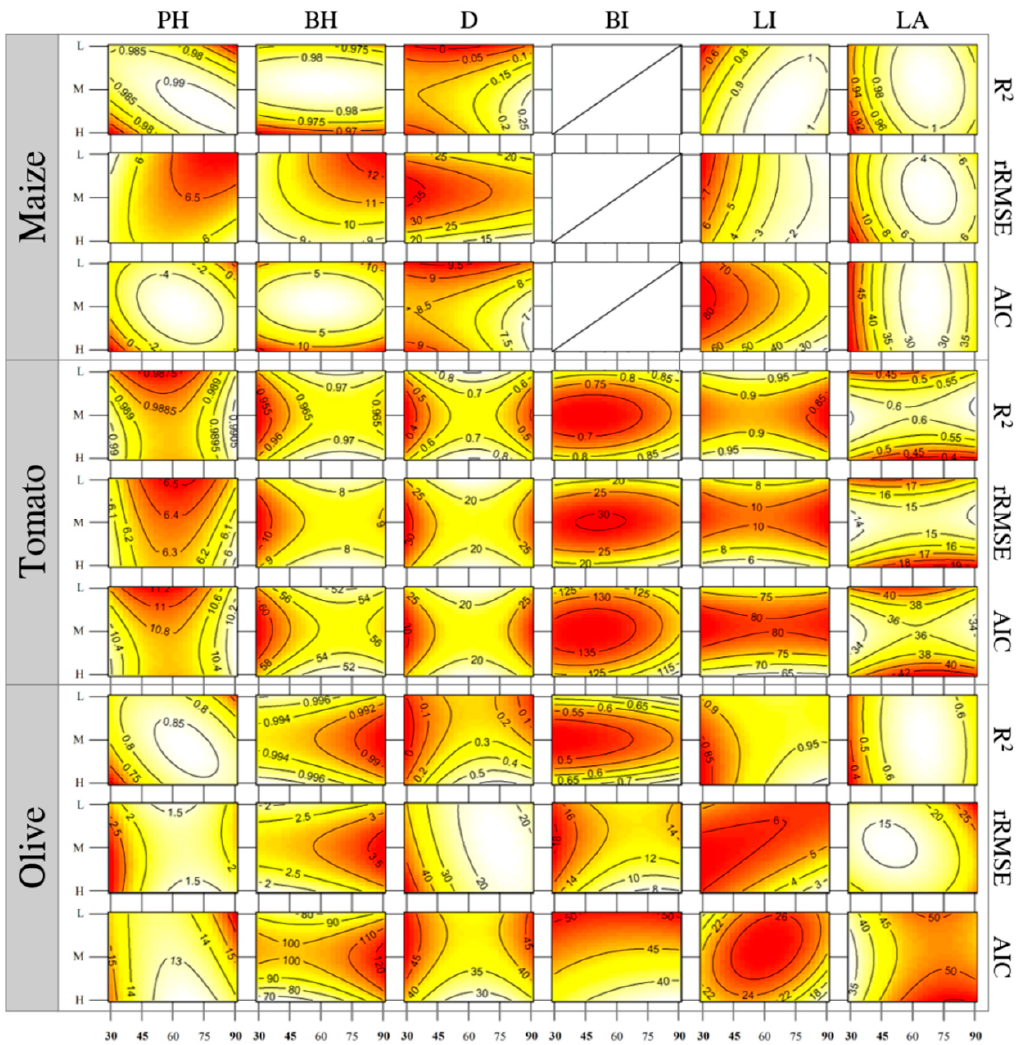
Figure 5. Response surface methodologies (RSMs) of maize (C), tomato (T) and olive-tree (O) plant heights ( PH and BH ; cm), merged basal, half-plant and apical stem diameter (D; mm), petioles / branches inclination ( BI ; deg), leaves’ inclination ( LI ; deg) and leaf area ( LA ; cm 2 ) predictors ( R 2 , rRMSE and AIC) related to image quantity (30, 45, 90; on the axis of ordinates) and quality (L, M, H; on the axis of abscissas) changes.